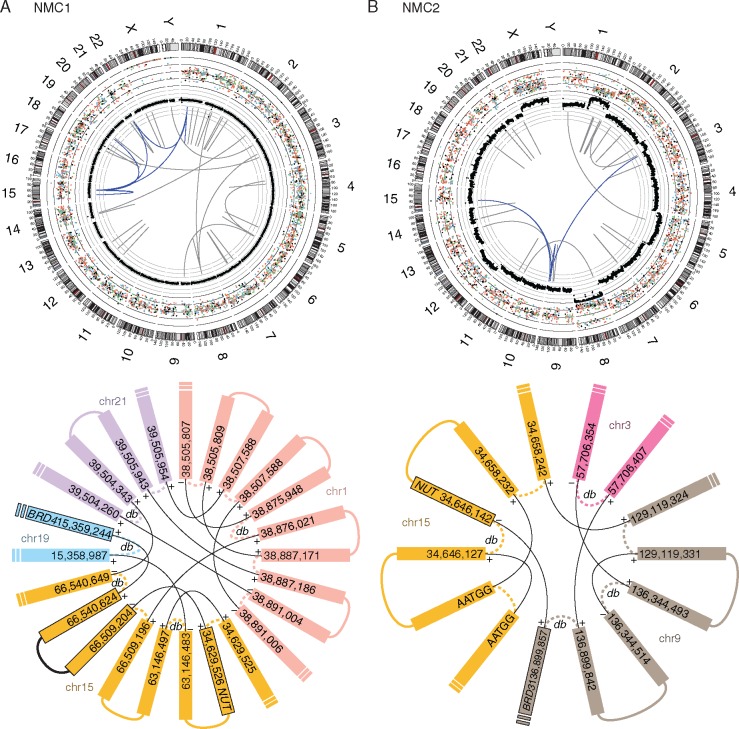
Chromoplexy generating the BRD3/4−NUT rearrangements. In the upper panels, genomic alterations of two cases (A; NMC1, B; NMC2) are described in circos plots. From the outside in, chromosomal ideograms and their genomic positions in megabases, base substitutions with their variant allelic fractions, smoothened copy numbers, and structural variations are plotted. Genomic rearrangements involved in the chromoplexy are highlighted in blue colors. For base substitutions, we use different colors for indicating different mutational spectra (C > A, blue; C > G, black; C > T, red; T > A, grey; T > C, green; T > G, pink). In the lower panels, the pattern of rearrangement and breakpoints of chromoplexy chains are described. Solid lines represent rearrangements, and dashed lines indicate DNA double strand breaks. >10-bp sized deletions overlying the double strand breaks are indicated as deletion bridges (db). Plus signs indicate rearrangement with reference strand, while minus signs indicate rearrangement with non-reference strand.